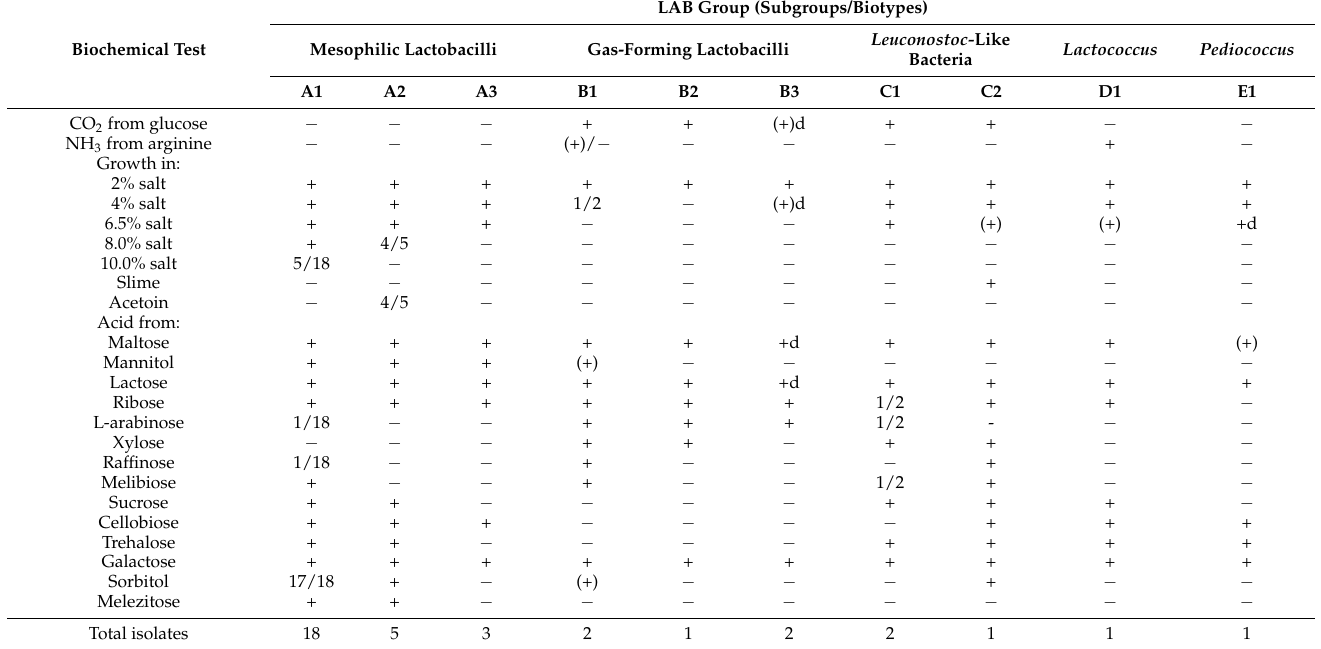
Table 5. Biochemical characterization of 36 mesophilic LAB isolates from four Galotyri PDO batches and their numerical distribution in each fresh (Brand-K) or ripened (Brand-Z) cheese